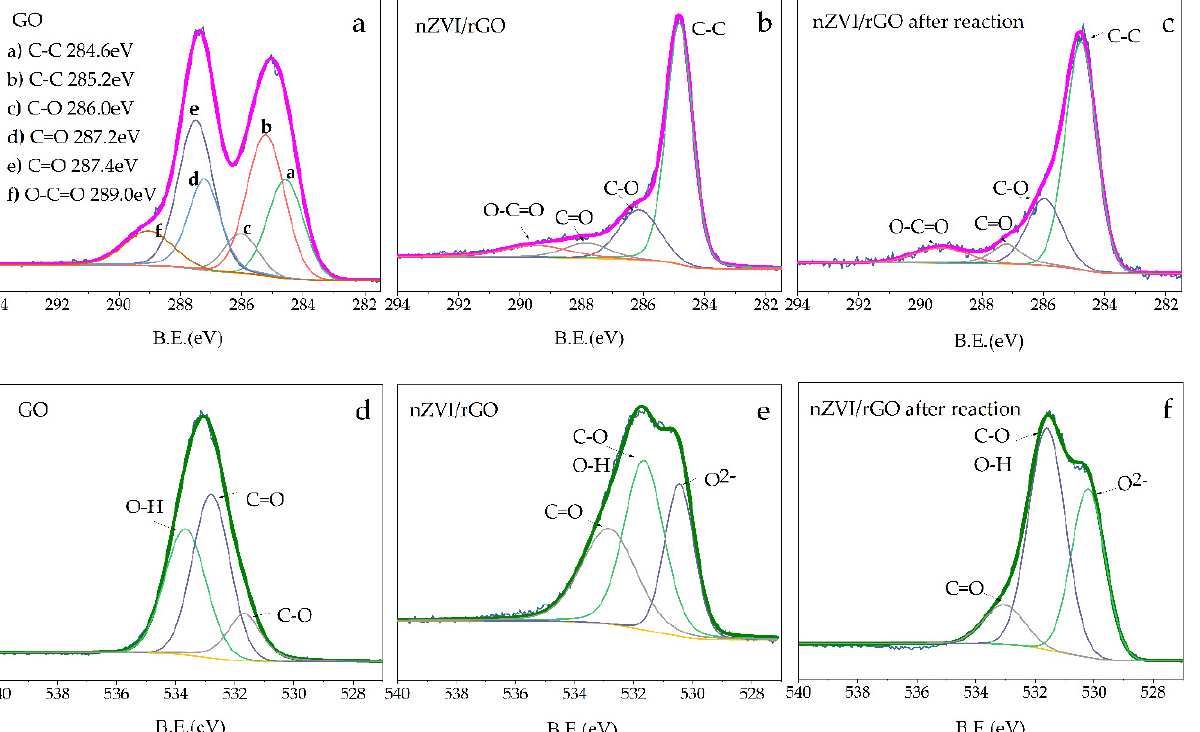
Figure 6. High-resolution XPS spectrum of ( a – c ) C 1s and ( d – f ) O 1s of GO, nZVI/rGO, and nZVI/rGO after reaction.